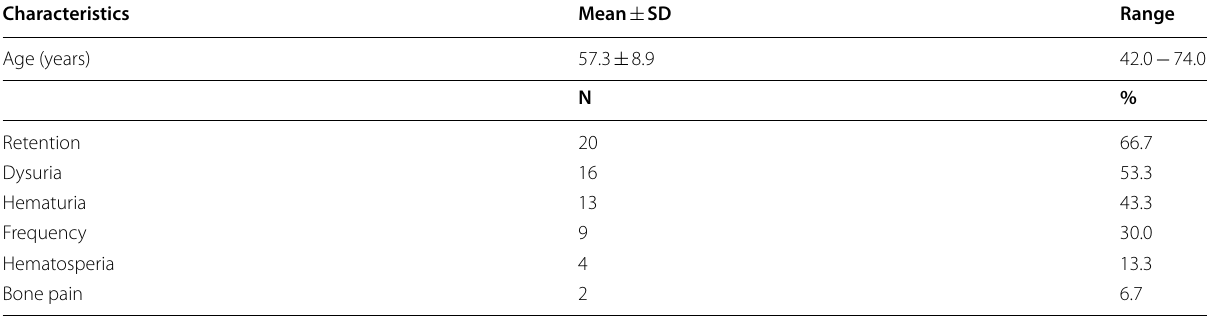
Table 1 Age and clinical presentation among the studied cases